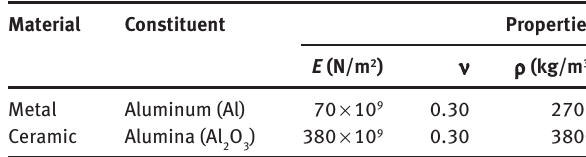
Table 1: Constituent material properties of FG plates [11].